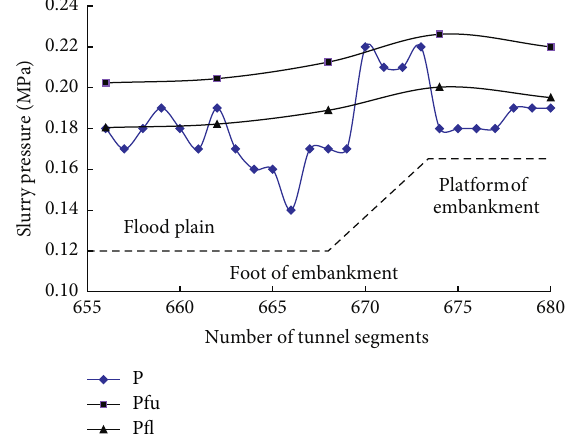
Figure 10: Curves of the actual slurry pressure during tunneling under the embankment.